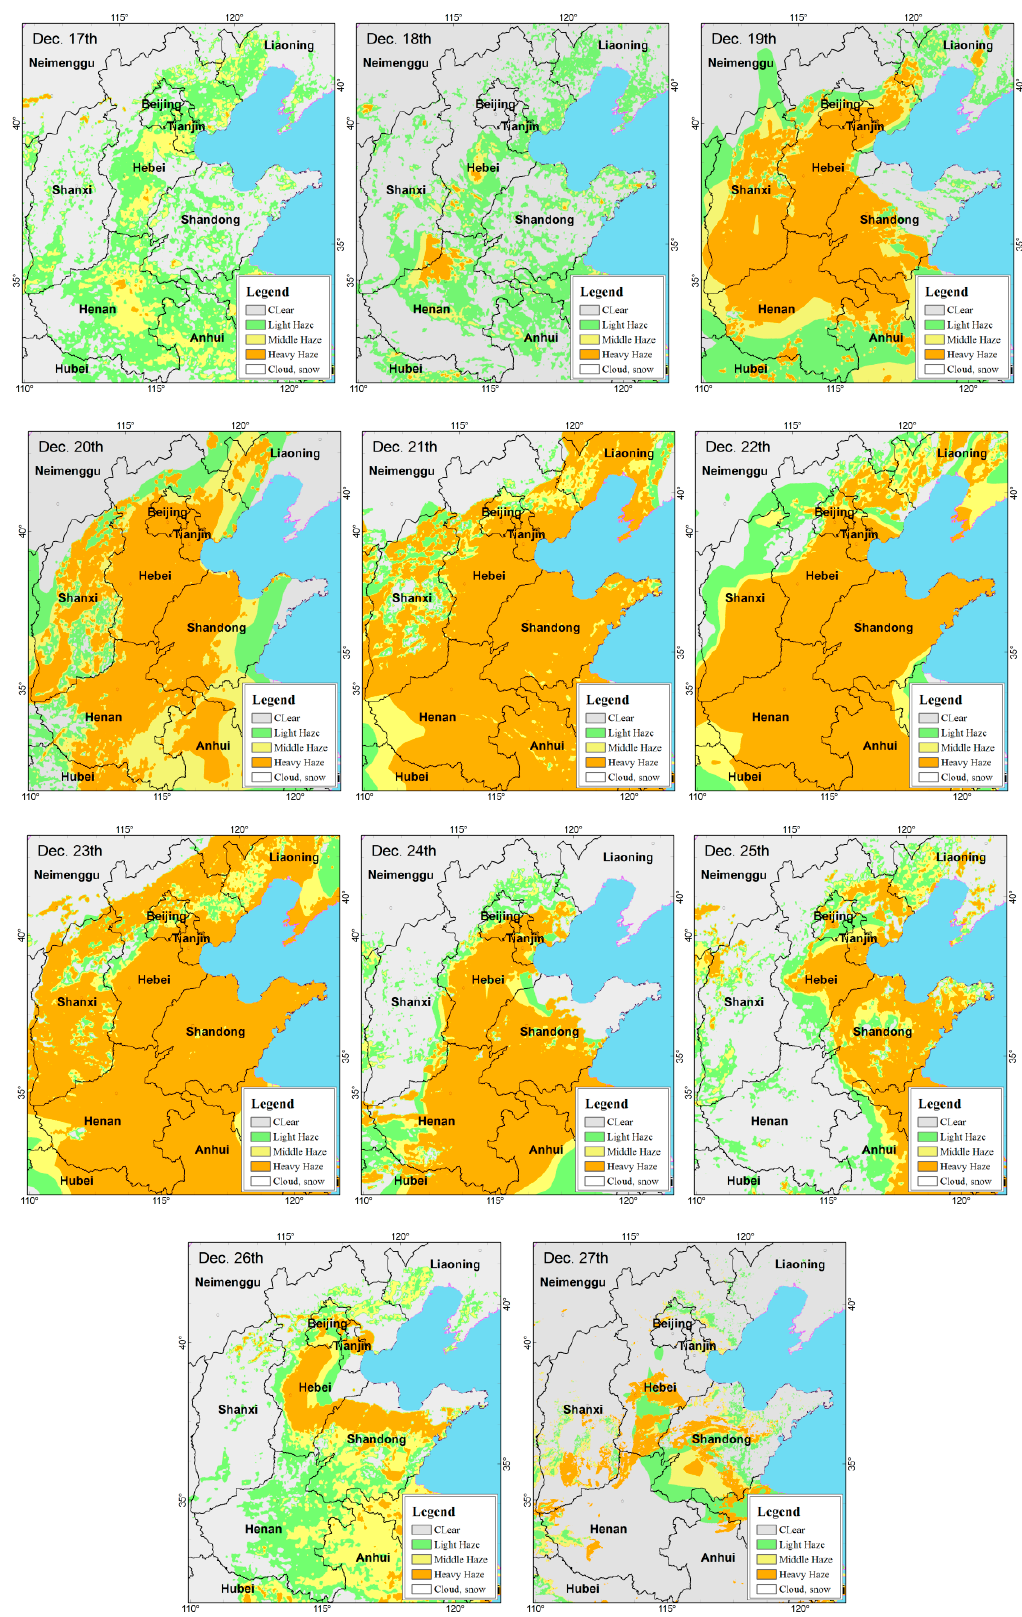
Figure 5. Daily variation of haze area from 17 December 2015 to 27 December 2015.